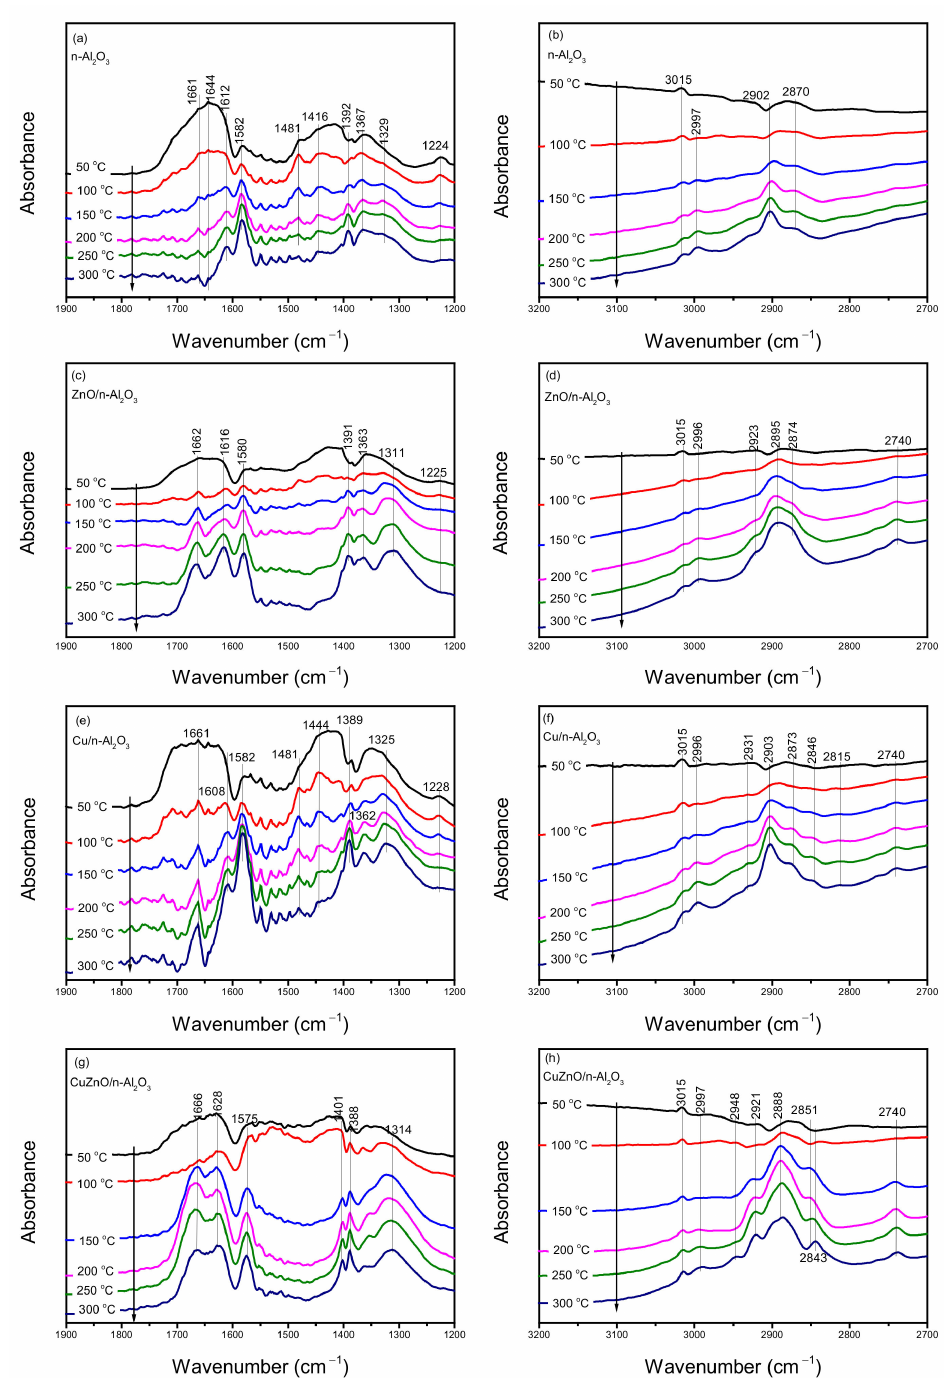
Figure 7. In situ DRIFT spectra of the reaction gas mixture of ( a , b ) n-Al 2 O 3 , ( c , d ) 3% ZnO/n-Al 2 O 3 , ( e , f ) 3% Cu/n-Al 2 O 3 , and ( g , h ) 3% CuZnO/n-Al 2 O 3 . Reaction conditions: CO 2 :H 2 = 1:3, gas flow rate = 30 mL min − 1 , P = 2.0